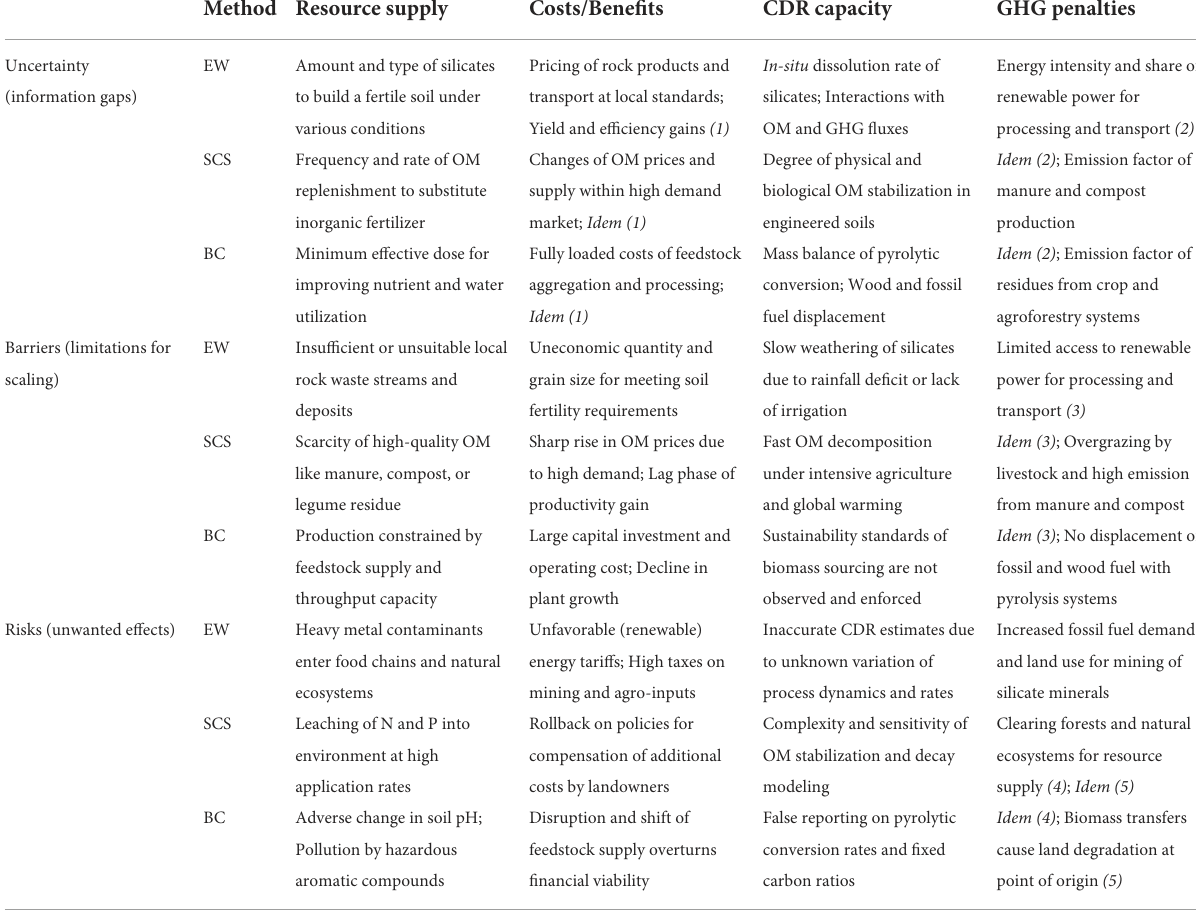
TABLE 1 Potential caveats for real-world deployment and climate impacts of the techniques in the proposed